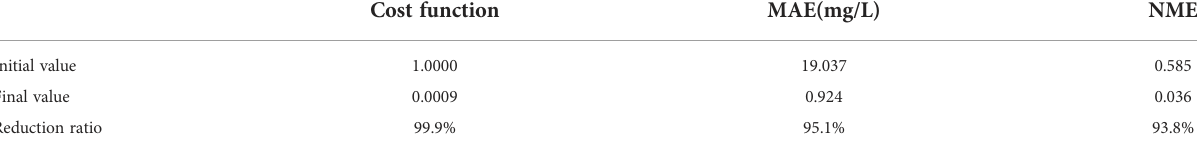
TABLE 2 The cost function, MAE and NME of Ideal Experiment II.